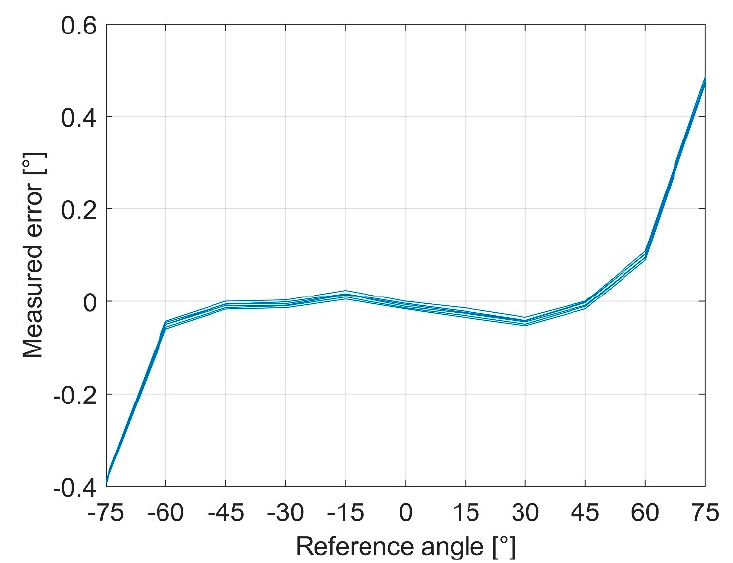
Figure 11. Error curve for the MID sensor measured on the test bench. The non-repeatability and the hysteresis were determined from the error curve and expressed in percent of the full-scale output (%